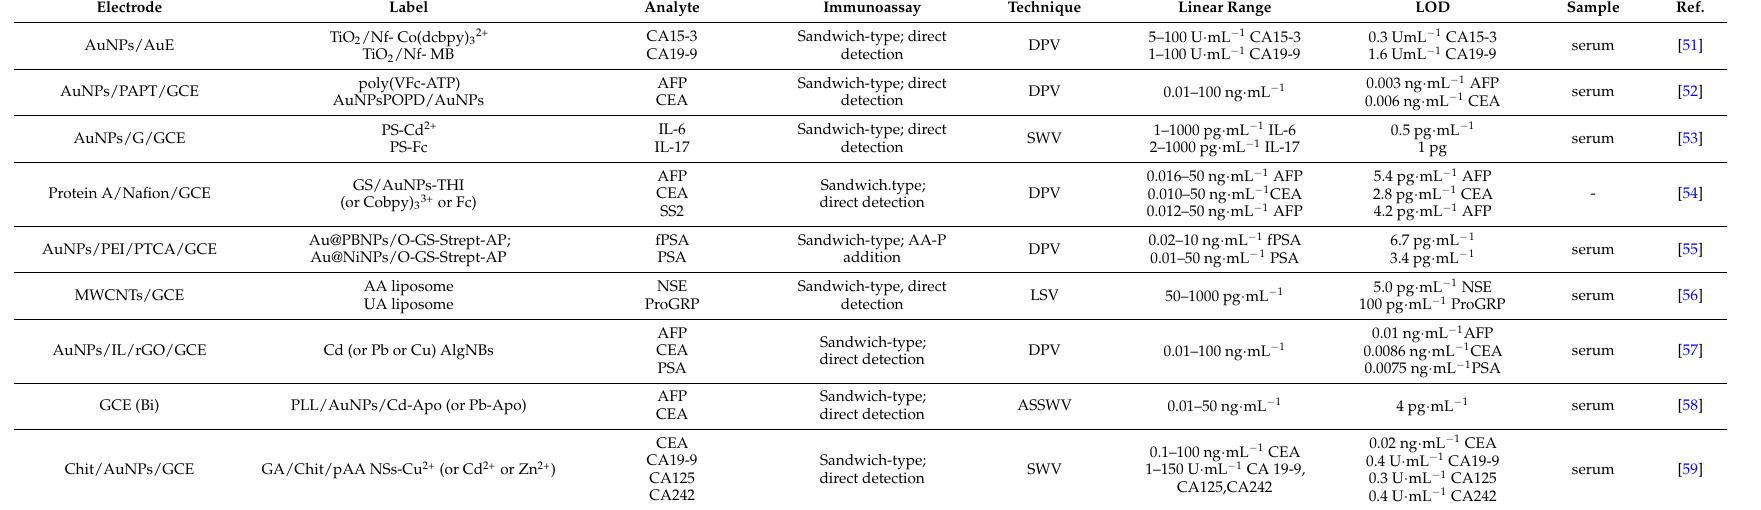
Abbreviations: AA, ascorbic acid; AA-P, ascorbic acid 2-phosphate; ACTP, apoferritin templated cadmium phosphates; AFP, alpha fetoprotein; AFP-L3, lens culinaris (LCA)-reactive fraction of AFP; AFU, alpha-L-fucosidase; AgNCs, silver nanoclusters; Alg, alginate; Apo, apoferritin; APT, abnormal prothrombin; ATLP, apoferritin templated lead phosphates; AU, uric acid; Bax, Bcl-2 associated X protein; Bcl, B-cell lymphoma; CEA, Chit, chitosan; CGN, carbon-gold nanocomposite; CGS, carboxyl graphene nanosheet; CNS, carbon nanospheres; DCP, des-c-carboxy prothrombin; Fc. ferrocene; fPSA, free-prostate specific antigen; FTO, fluorine-doped tin oxide; G, graphene; γ -GT, γ -glutamyltranspeptidase; GCE, glassy carbon electrode; O-GS, onion-like graphene sheet; HER-2, human epidermal growth factor receptor type-2; HRP, horse-raddish peroxidase; IL, ionic liquid; NPG, nanoporous gold; NSE, neuron-specific enolase; OMC, ordered mesoporous carbon; pAA, polyacrylic acid; PATP, poly(2-aminothiophenol); PB, Prussian blue; PDPMT-Cl, blue; THI, thionine; UA, uric acid; VFc-ATP, vinyl